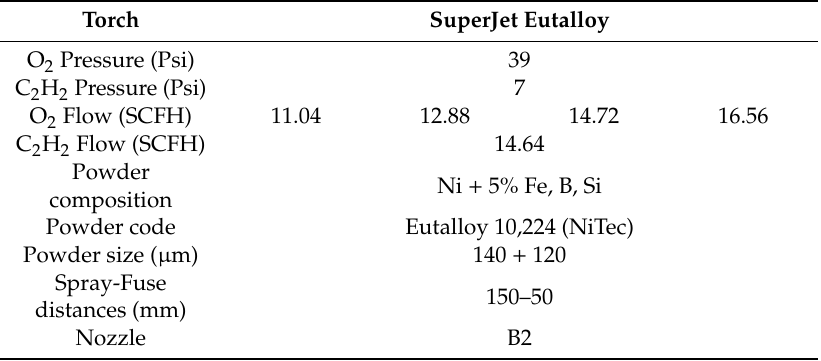
Table 1. Deposition conditions of the